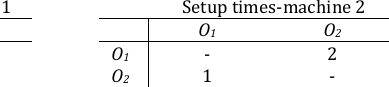
Illustrative example.